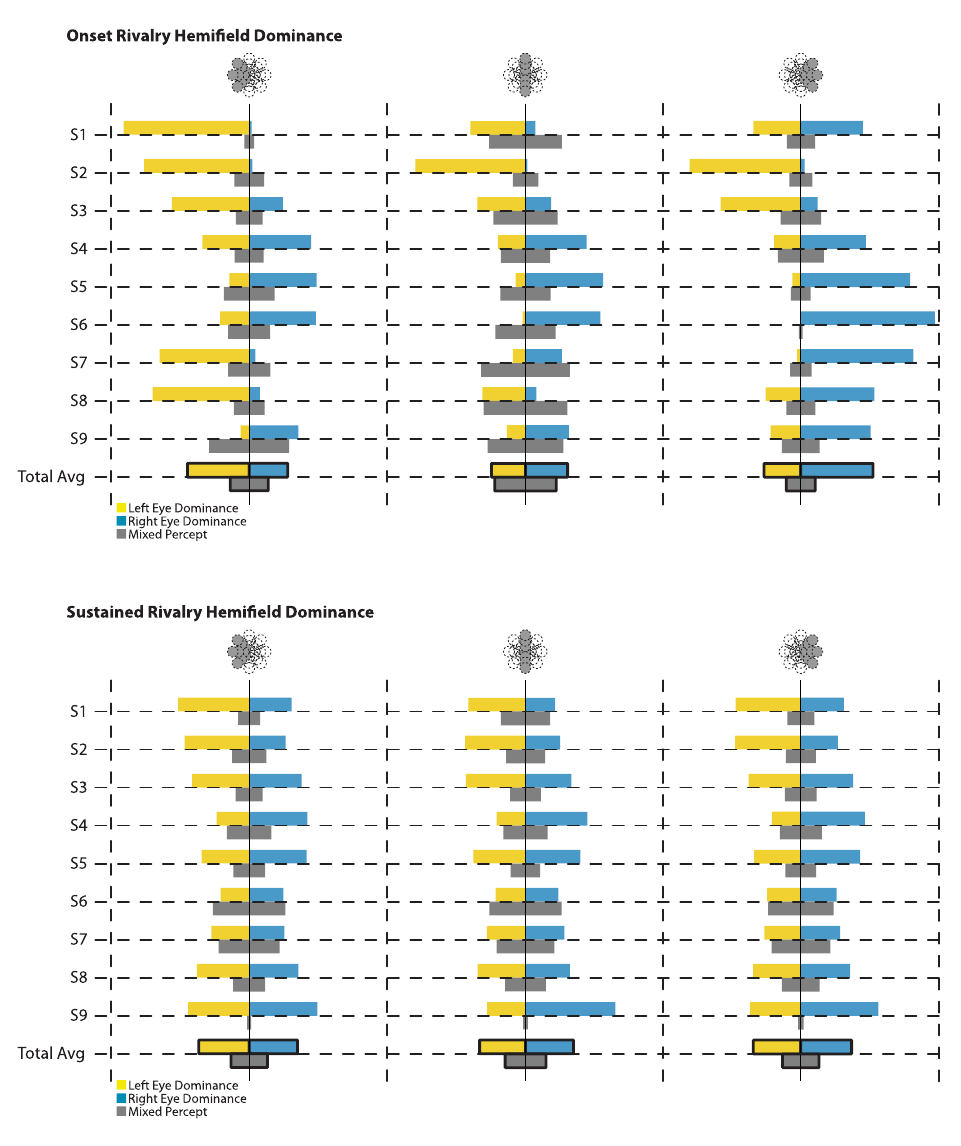
Figure 3. Hemifield Dominance: At the onset of rivalry, the net proportion of left eye dominance, right eye dominance, and mixed percept varies by region of the visual field. During sustained rivalry, left eye and right eye dominance still differ in the left and right hemifields, but mixed percept does not significantly differ across regions.